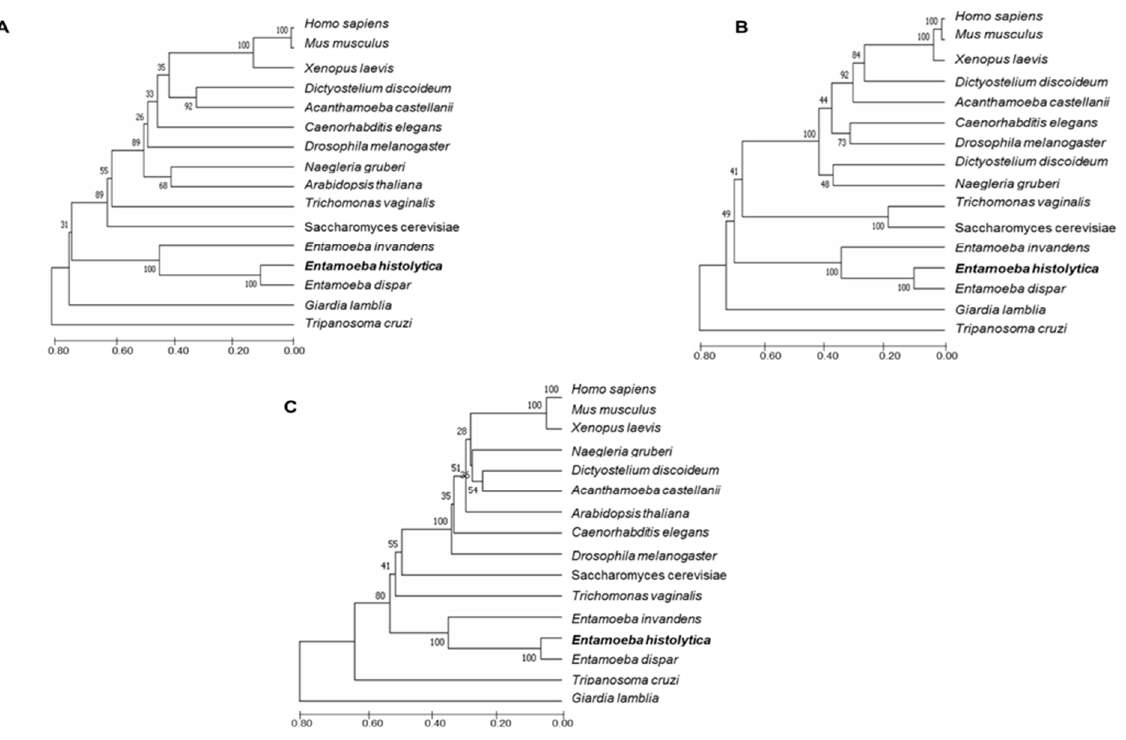
Figure 1 . Phylogenetic trees of EhVps22, EhVps25, and EhVps36. ( A – C ) ESCRT-II proteins could come from a common ancestor with other organisms. The position of E. histolytica ESCRT-II proteins is in bold. Left numbers: confidence percentages of the tree topology by bootstrap analysis of 1000 replicates.